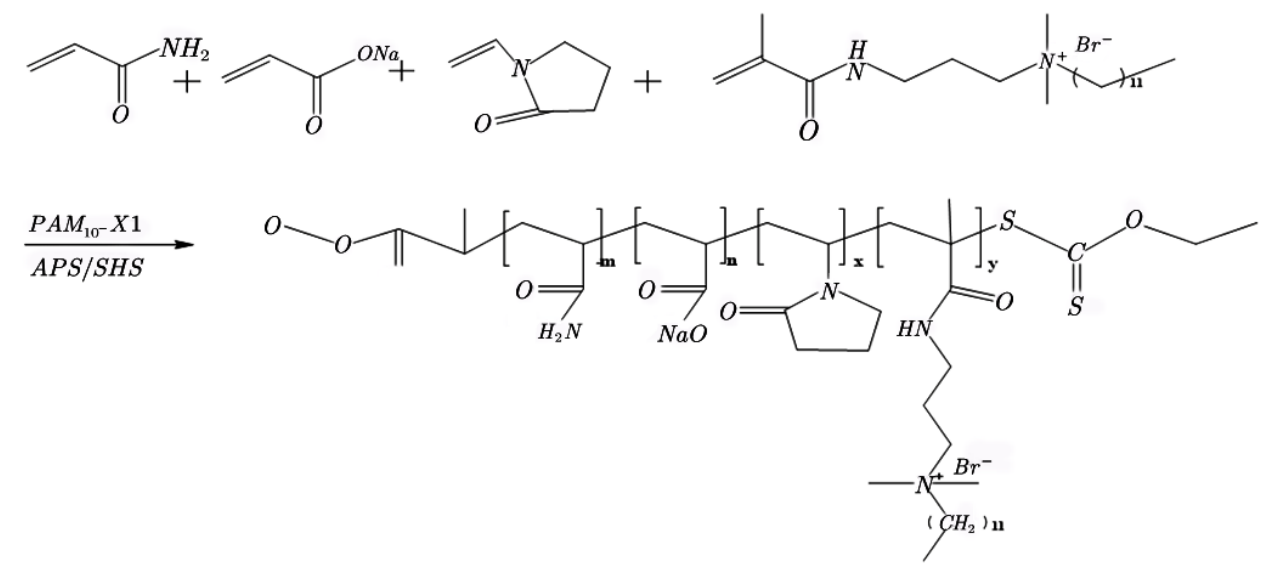
Figure 6. Reaction path followed to obtain the hydrophobic associative polymer.